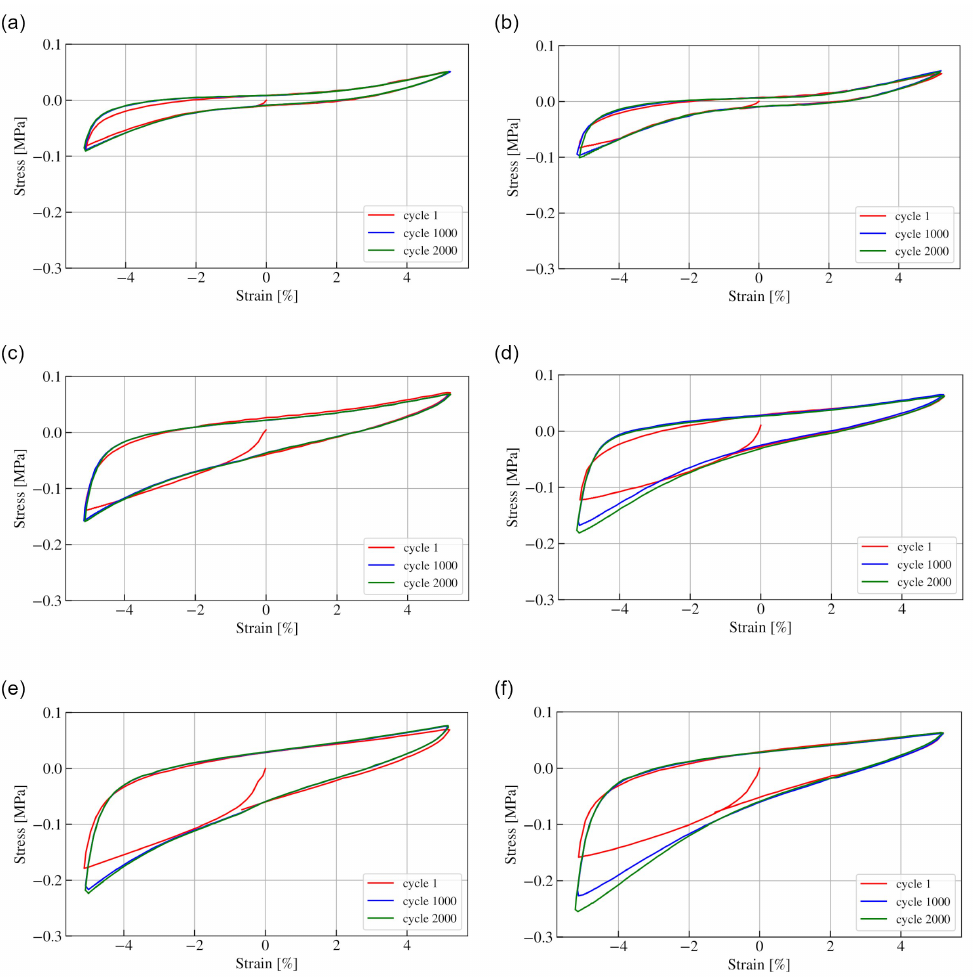
Figure 3. Hysteresis loops representing 1, 1000 and 2000 cycles for POM ( a , c , e ) and PP ( b , d , f ) for underpressures of 0.01, 0.04 and 0.07 MPa,